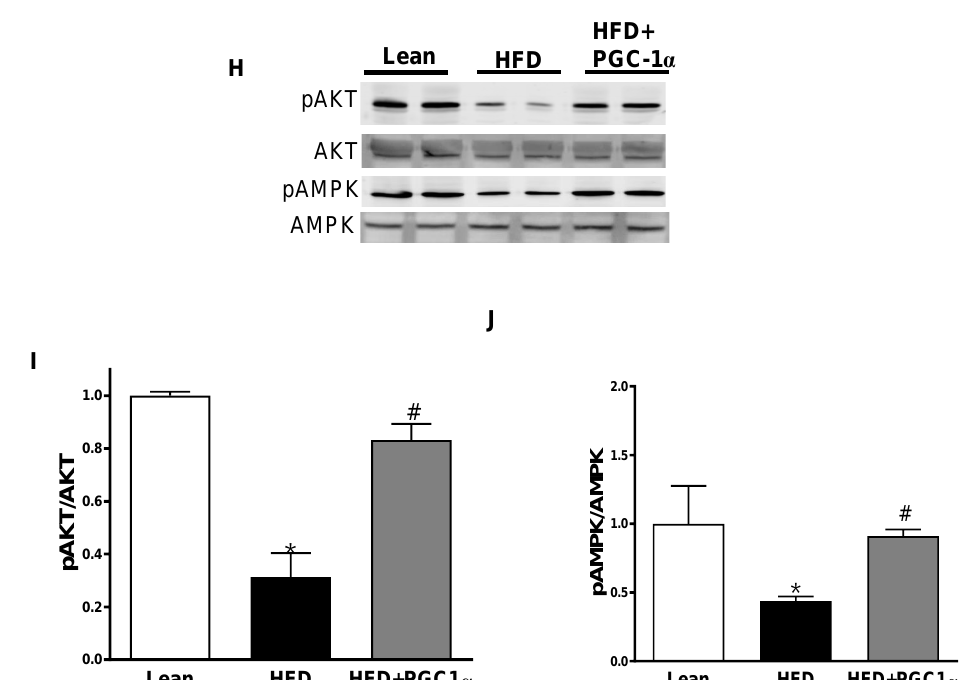
Figure 5. Expression of inflammatory mediators and insulin signaling in the adipose tissue of lean, high-fat-diet (H.F.D.)-fed, and Transgenic-adipo-PGC-1 α mice. Representative Western blot analysis of ( A – D ) MEST, NOV/CCN3 and TWIST, ( E – G ) FGF21 and phosphorylated insulin receptor tyrosine 972 (pIRTyr972), ( H – J ) pAKT and pAMPK with their corresponding A.K.T. and AMPK in the adipose tissue of lean, H.F.D., and Transgenic-adipo-PGC-1 α mice. Data are expressed as mean ± S.E.M. ( n = 5); * p < 0.05 vs. lean; # p < 0.05 vs.